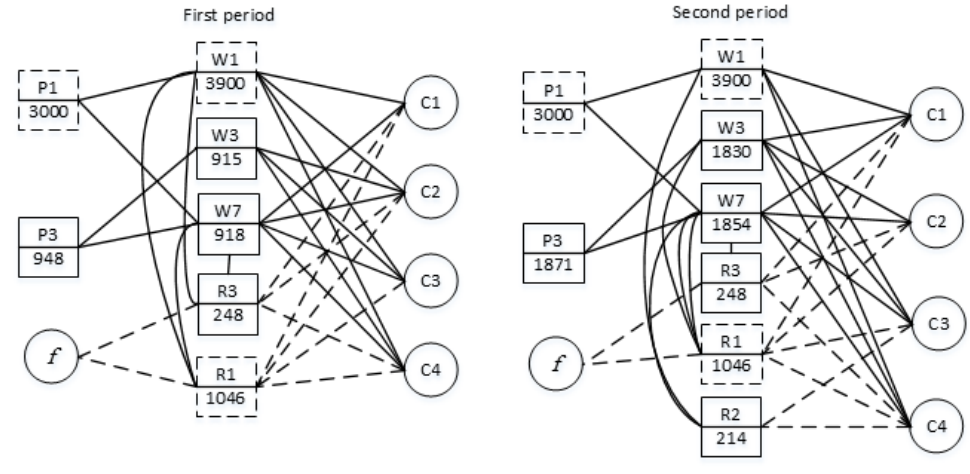
Fig. 2. Network structure for first, second periods and scenario